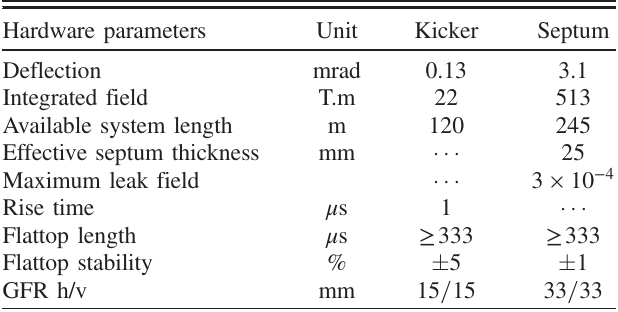
TABLE III. Parameters of kicker and septum for FCC extrac- tion for the baseline